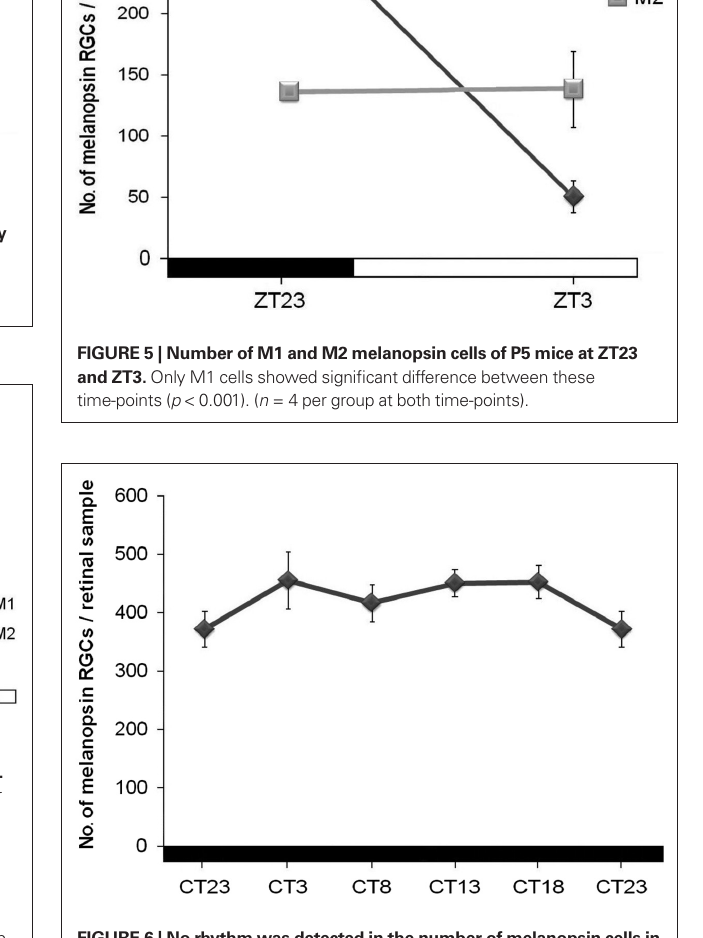
FIGURE 6 | No rhythm was detected in the number of melanopsin cells in DD conditions (ANOVA test: p > 0.05). ( n = 4 at each